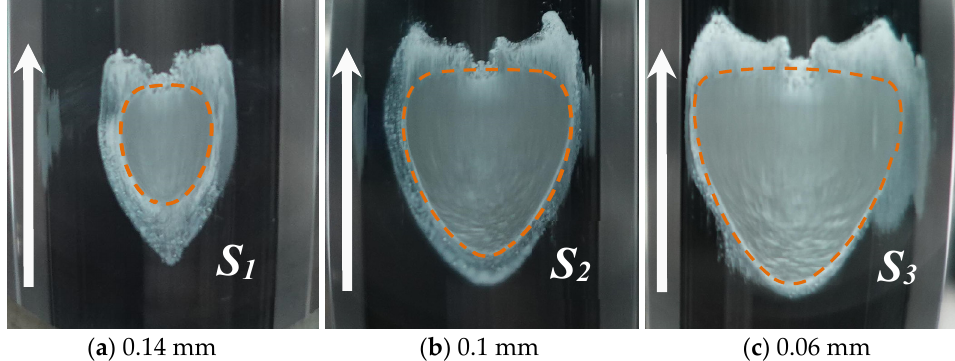
Figure 14. Schematic diagram of finishing area observation.